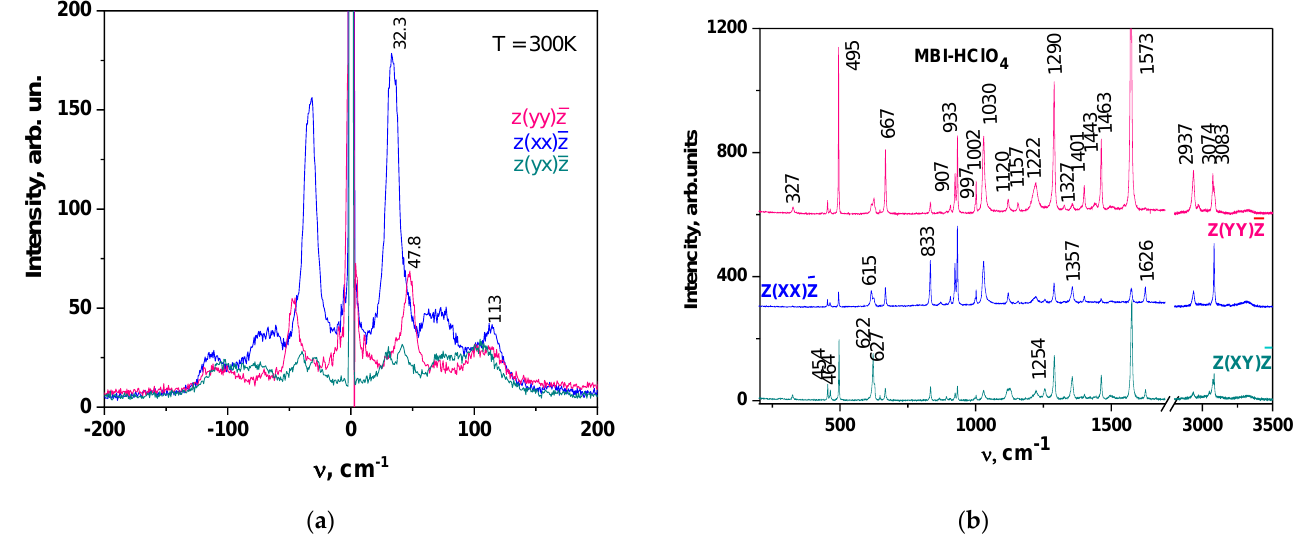
Figure 4. Raman spectra of MBI-perchlorate crystal for different experimental geometries. ( a ) Low energy region (−200– 200 cm −1 ) with Stokes and anti-Stokes components, ( b ) Spectral region 100 -3500 cm −1 . Measurements of FTIR absorption spectra were carried out using thick and thin sam- ples (Sample 1). The thin sample (thickness h ~0.1 mm) was measured in transmission mode, and the thick sample ( h ~0.5 mm) was measured in both transmission and specular reflection modes with subsequent Kramers-Kronig transformation. Transmission meas- the ranges of 1700 – 2850 and 3850 – 4800 cm −1 . The absorption peaks in the ranges of 650 – 1700 cm −1 and 2850 – 3100 cm −1 are better seen on measurements of a thin sample. Figure 5